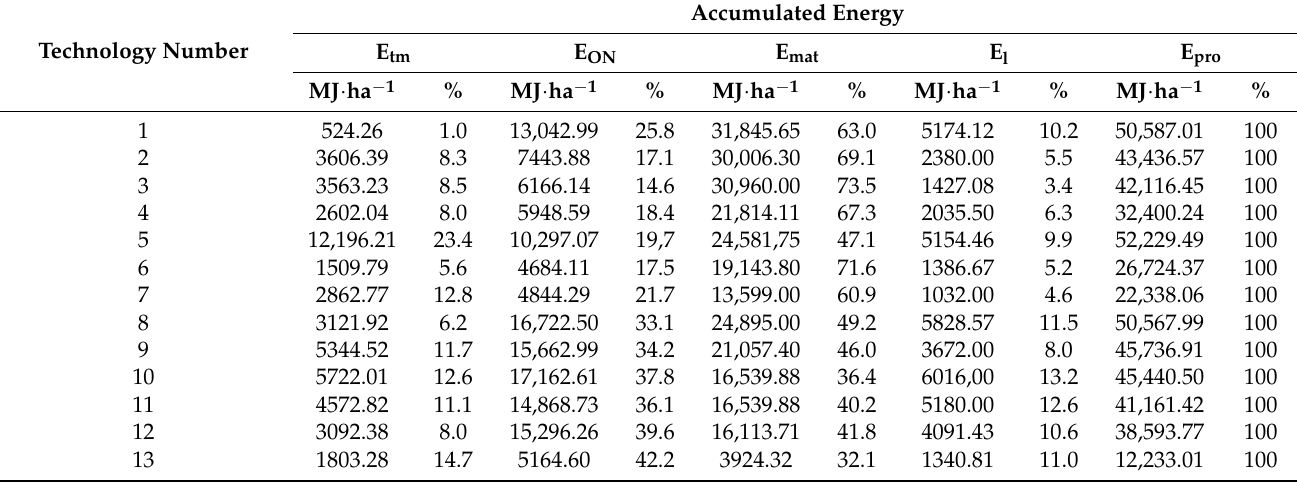
Table A1. Value of accumulated energy consumption and the percentage share of accumulated energy in individual energy inputs for the technologies studied.